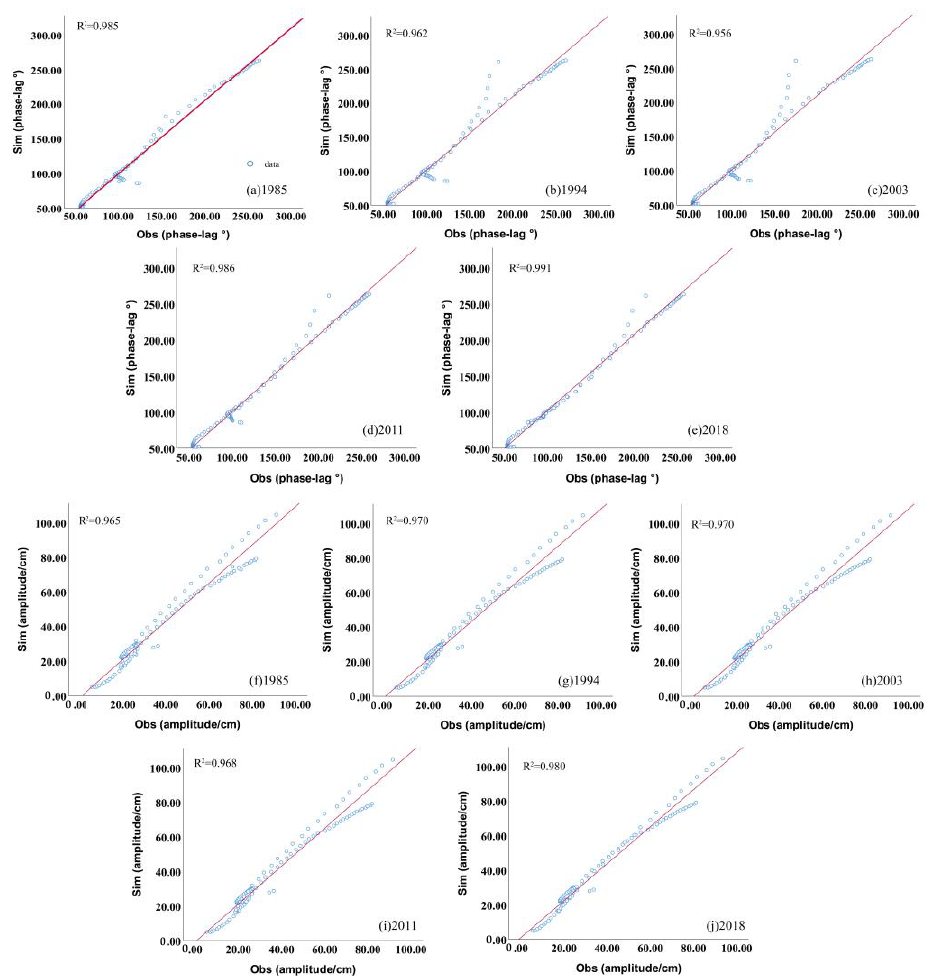
Figure 4. Deviations between the simulated results and observations of five years ( a – e ) denote phase lag (°), and ( f – j ) denote amplitude (cm). Table 3. The deviations between the simulated results and observations at T/P points in different periods.